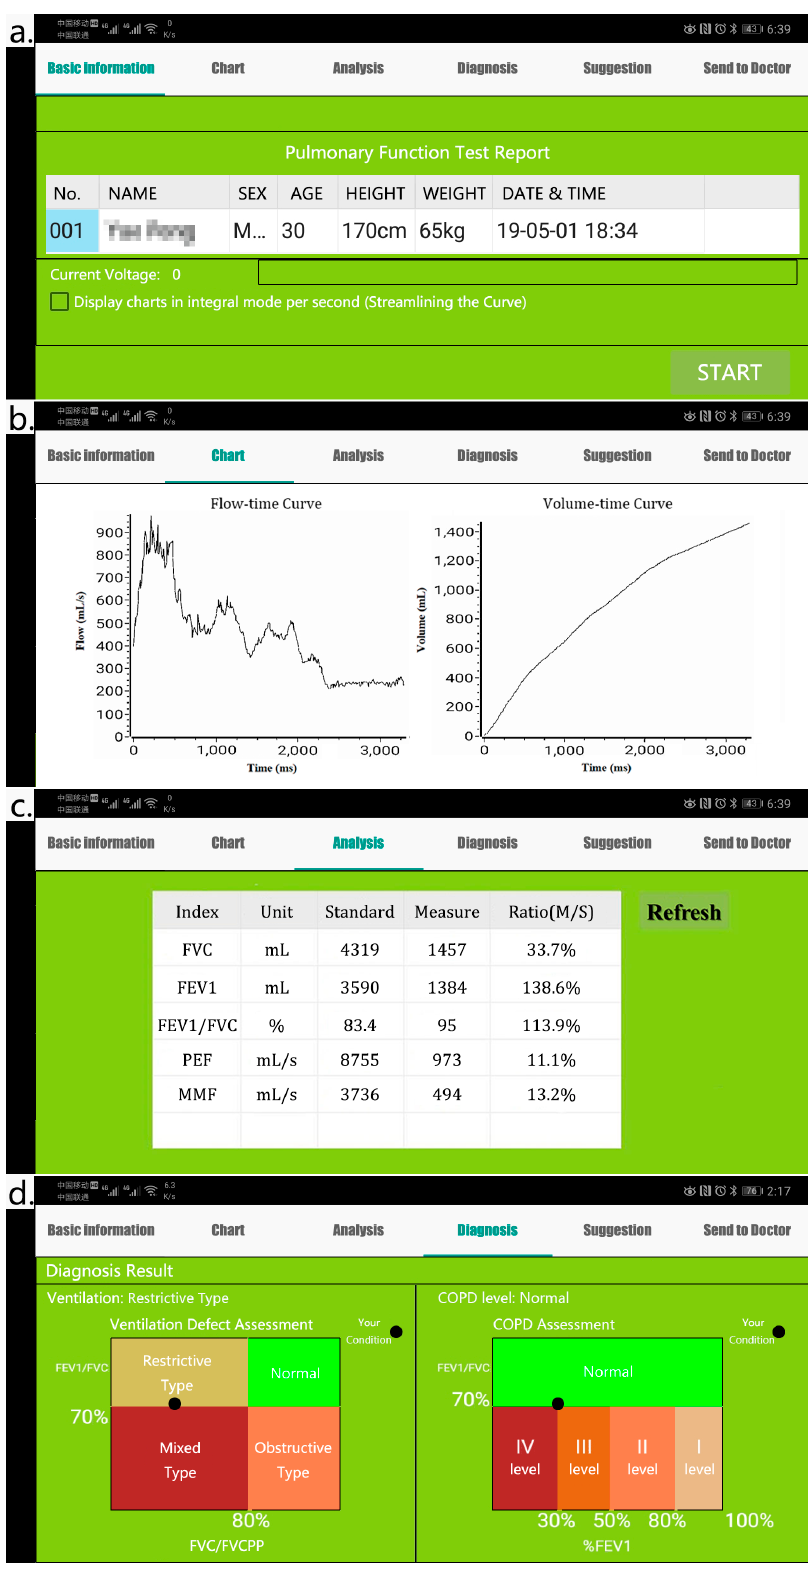
Figure 8. The displays of the smartphone app following a patient’s use of the developed spirometry test system. ( a ) the basic information of the person; ( b ) the flow-time curve and volume-time curve of the test, ( c ) the detailed data of FVC, FEV1, FEV1/ FVC, PEF and MMF; ( d ) the ventilation defect and COPD level assessments of the person.